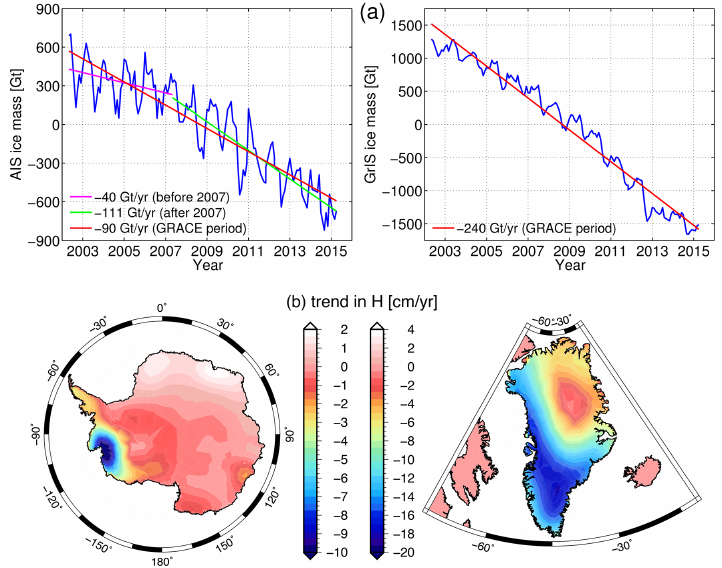
Figure 3. Summary of the GRACE data used in this study. (a) Ice mass change in the AIS and GrIS from April 2002 to March 2015. (b) Spatial distribution of rate of change in ice thickness, averaged over the GRACE period. See Sect. 4.1 for a detailed discussion of the GRACE data processing.